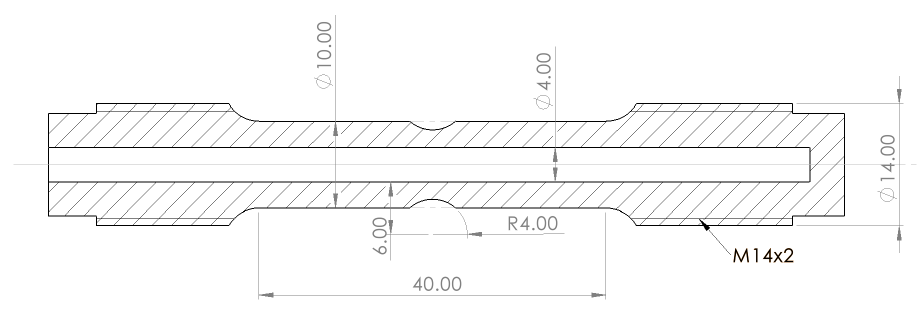
Figure 3. Technical drawing of the sample geometry. Dimensions are given in